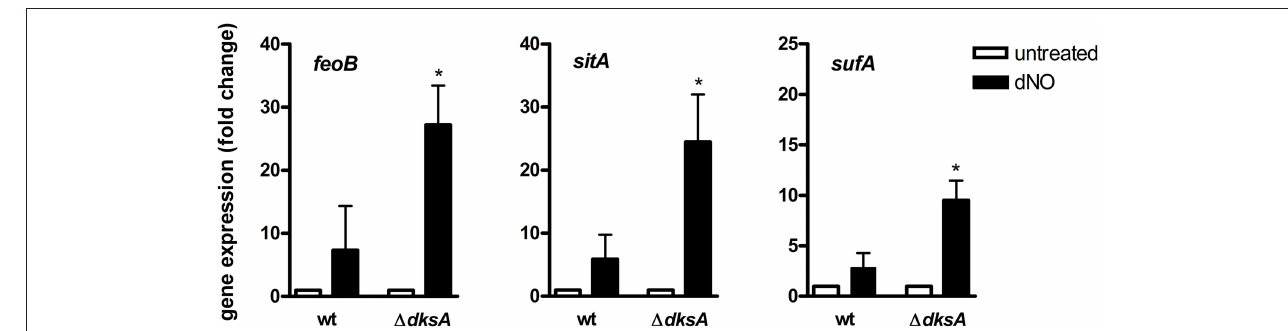
FIGURE 3 | • NO- and DksA-dependent transcriptional control of iron homeostasis. The expression of feoB , sitA , and sufA in wild-type (wt) and 1 dksA Salmonella treated ± 5mM dNO for 30 min was determined using qPCR. Gene expression, normalized to the house-keeping gene rpoD , is expressed as fold change compared to the respective untreated control. Data are the mean ± SEM, n = 3; * p < 0.05 as compared to dNO-treated wild-type bacteria.